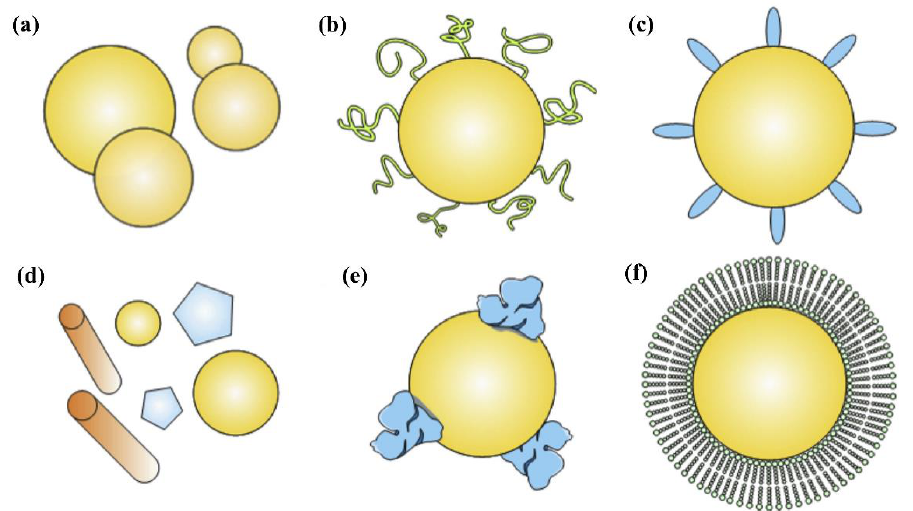
Figure 4. Strategies to prolong the half-life of PNs in the circulatory system by adjusting their physical characteristics, such as ( a ) size and ( b ) shape; or by ( c – f ) surface chemistry including ( c ) PEGylation and coating of PNs with ( d ) human serum albumin, and “self” markers such as ( e ) peptides or ( f ) cell-based membranes extracted from leukocytes and red blood cells [32]. Reprinted with permission from ref. [32]. Copyright 2017 Elsevier.